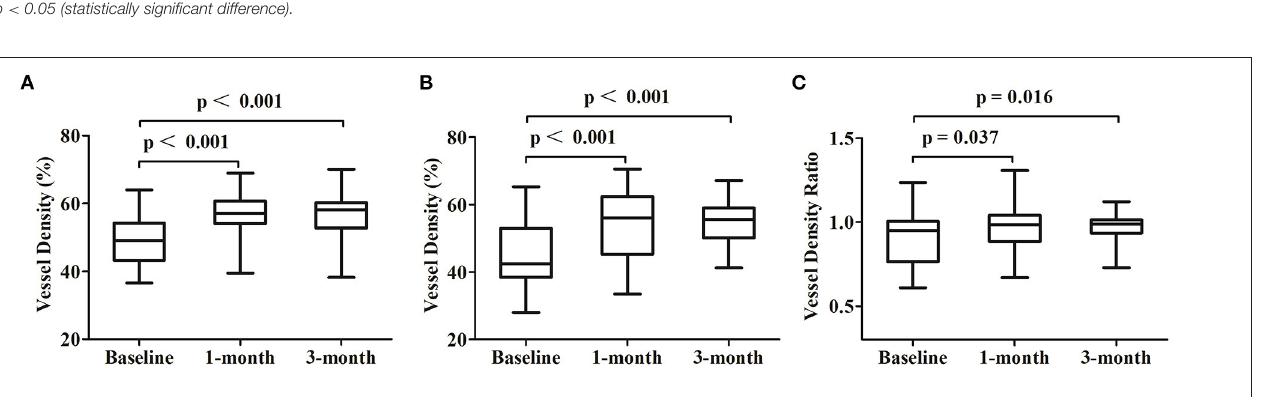
FIGURE 3 | Changes of the optical coherence tomography angiography parameters at each follow-up visit. (A) Comparisons of the vessel density at the whole area of the superficial choroidal layers. (B) Comparisons of the vessel density at the target 3 × 3 area of the superficial choroidal layers. (C) Comparisons of the vessel density ratio of the superficial choroidal layers.